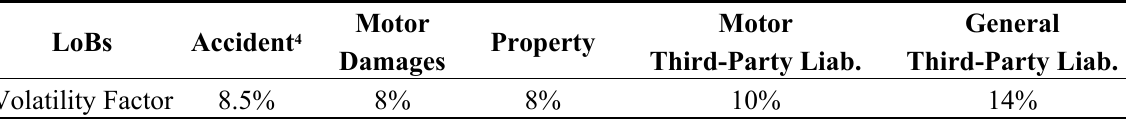
(DA—Premium 𝑝𝑟𝑒𝑚,𝑙𝑜𝑏